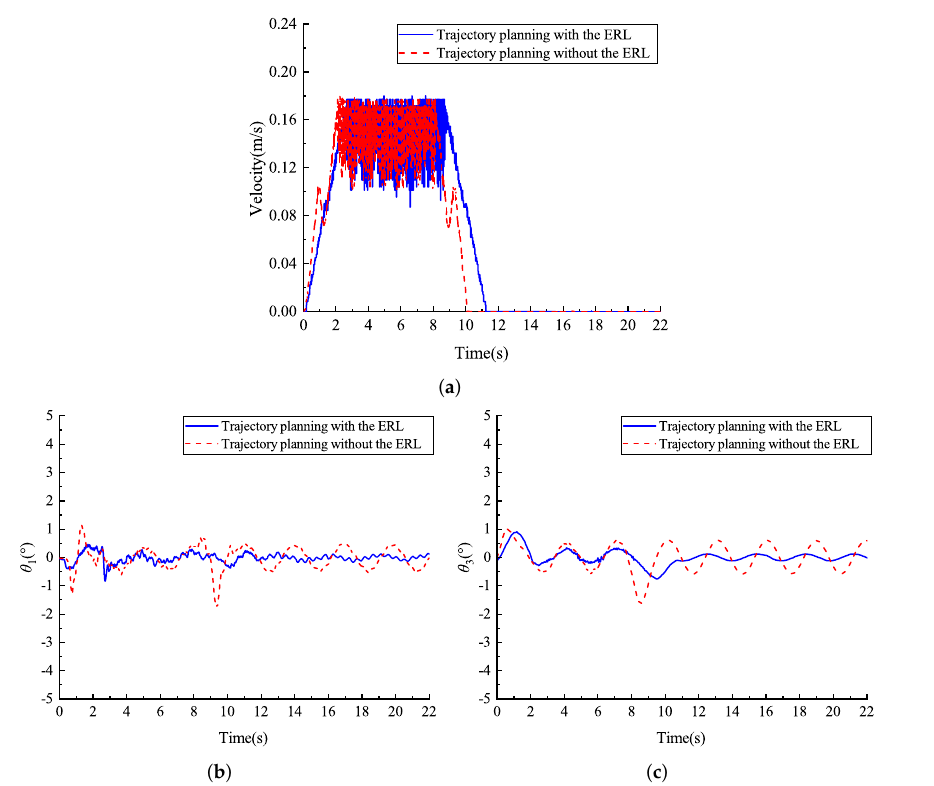
Figure 6. Comparative experimental results of the trajectory planning with the ERL and without the ERL. ( a ) velocity trajectories. oscillation responses of the hook ( b ) and DMP ( c ).